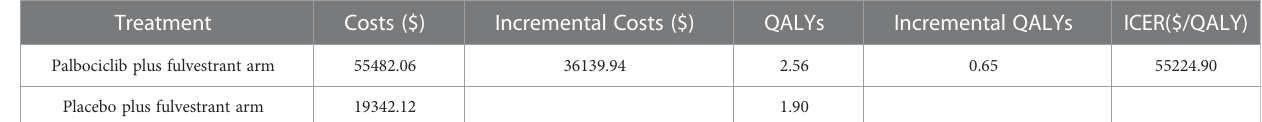
TABLE 2 Base case results.